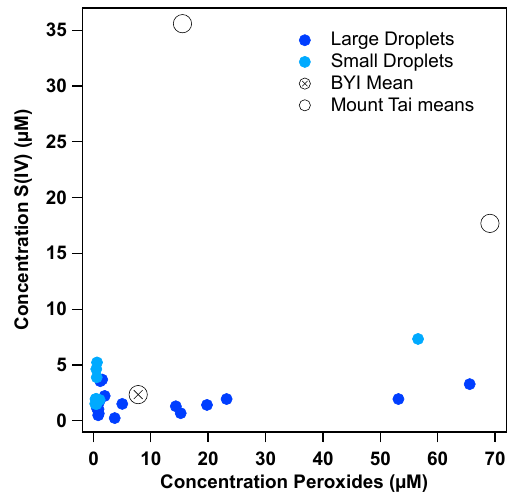
Figure 5. Droplet size-segregated concentrations of S(IV) and per- oxides quantified in BYI fog samples. S(IV) concentrations were low in BYI fog as compared to those measured at Mount Tai (sum- mer 2007 and 2008; Shen et al., 2012). For both species, n =